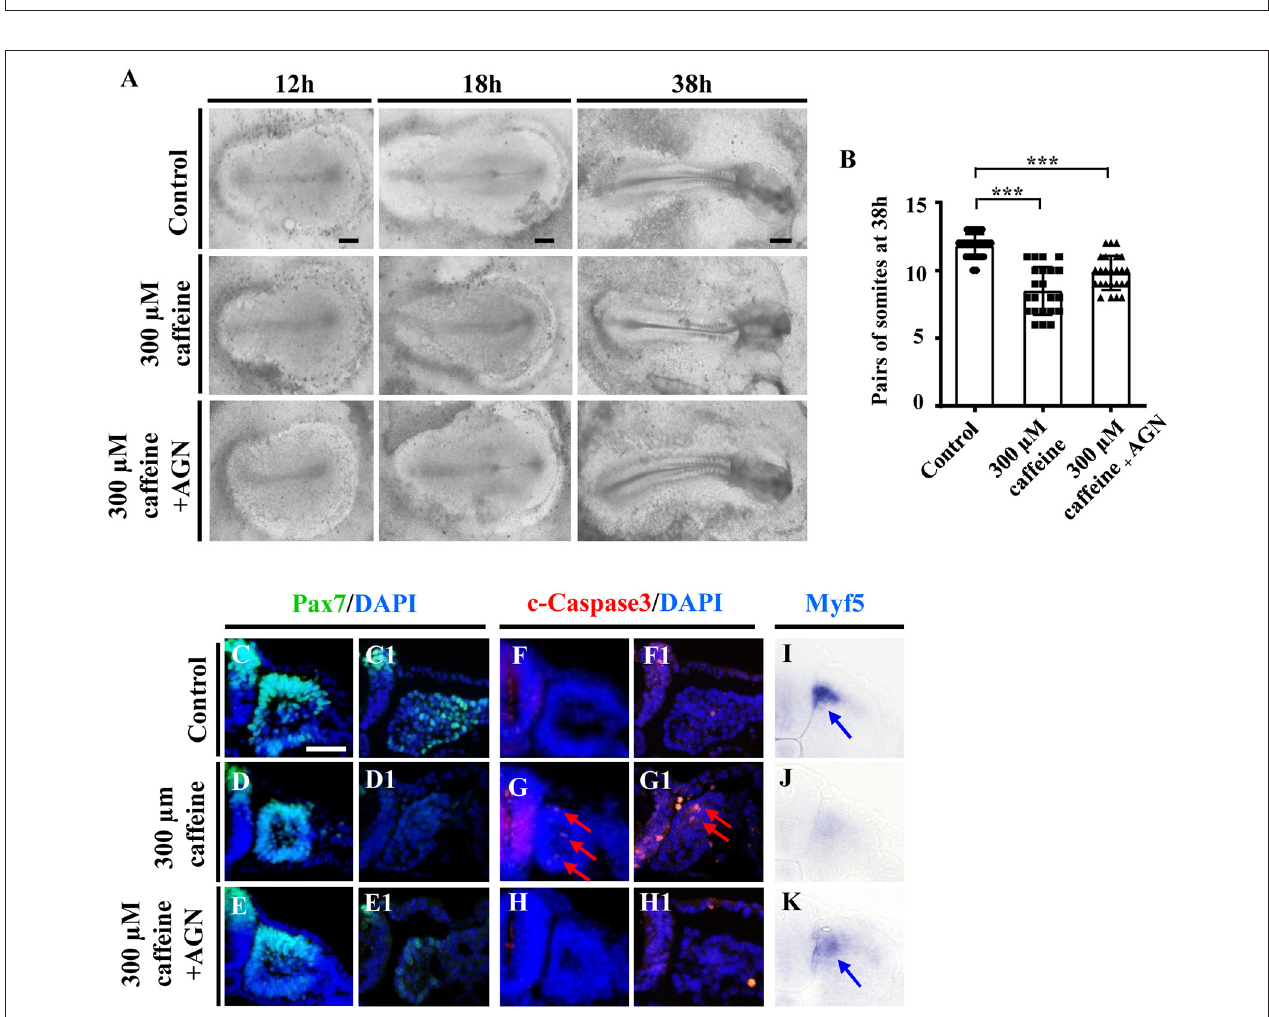
FIGURE 5 | Determination of the expression of cell apoptosis and differentiation in the developing somites following caffeine treatment and blockage of retinoic acid (RA) signaling. (A) Representative images of the 12th-, 18th-, and 38th-h whole chicken embryos from the control, caffeine-treated, and caffeine + AGN-treated groups. (B) The bar charts showing the comparisons of somite pairs chicken embryo between the control, caffeine-treated, and caffeine + AGN-treated groups at 38h. (C–H) Immunofluorescence staining of Pax7 or c-Caspase3 in the transverse sections from the control (C,C1,F,F1) , caffeine-treated (D,D1,G,G1) , and caffeine + AGN-treated (E,E1,H,H1) groups, and merge with DAPI staining. (I–K) The transverse sections of whole-mount in situ hybridization for Myf5 in the chicken embryos from the control (I) , caffeine-treated (J) , and caffeine + AGN-treated (K) groups. Panels (C/D/E,F/G/H,I/J/K) are from the seventh pairs of somites; ( C1/D1/E1,F1/G1/H1) are from the presomitic mesoderm (PSM) of somites. Scale bars = 500 µ m in panel (A) ; 50 µ m in panels (C–K) . *** P <